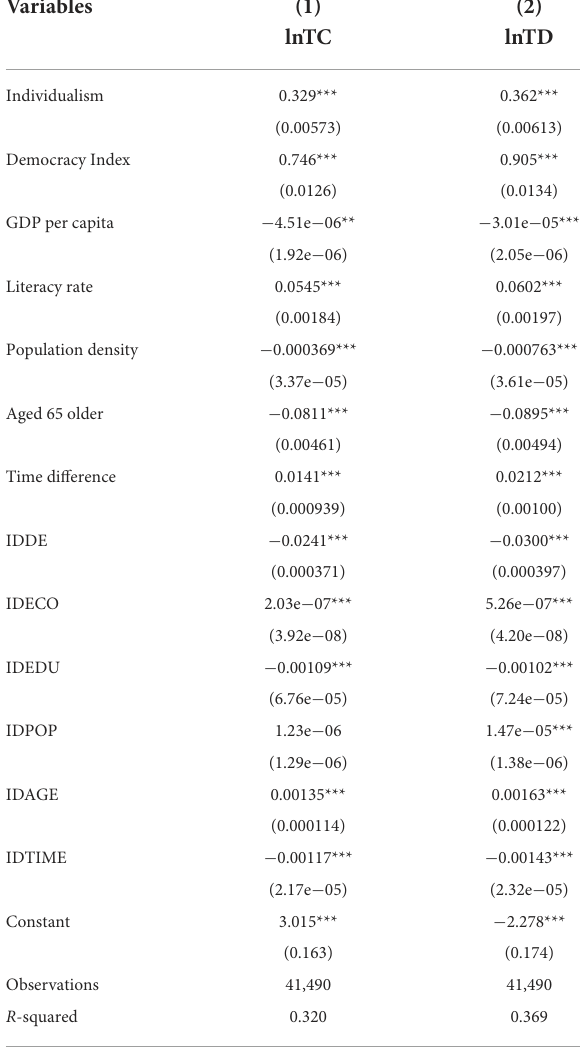
TABLE 10 Moderating effect of control